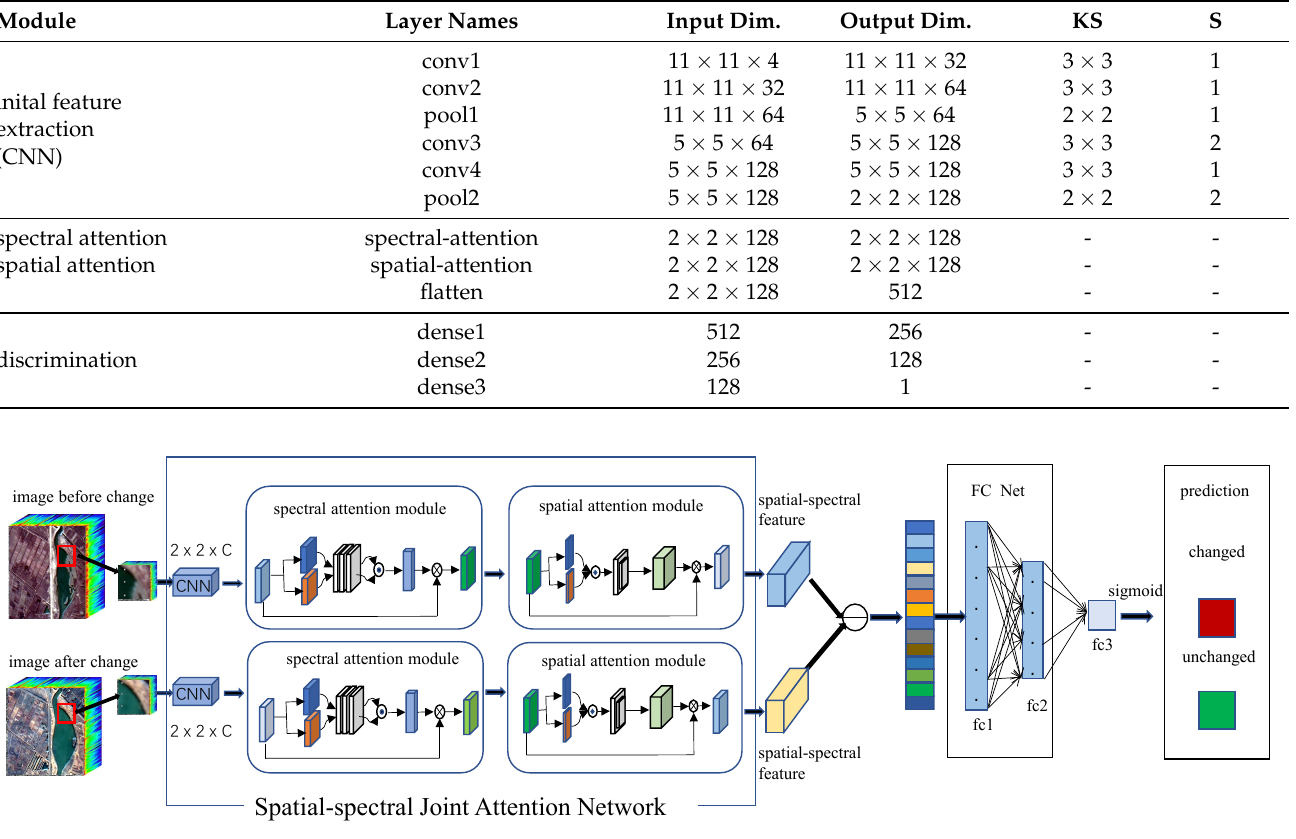
Figure 1. Spatial–spectral joint attention